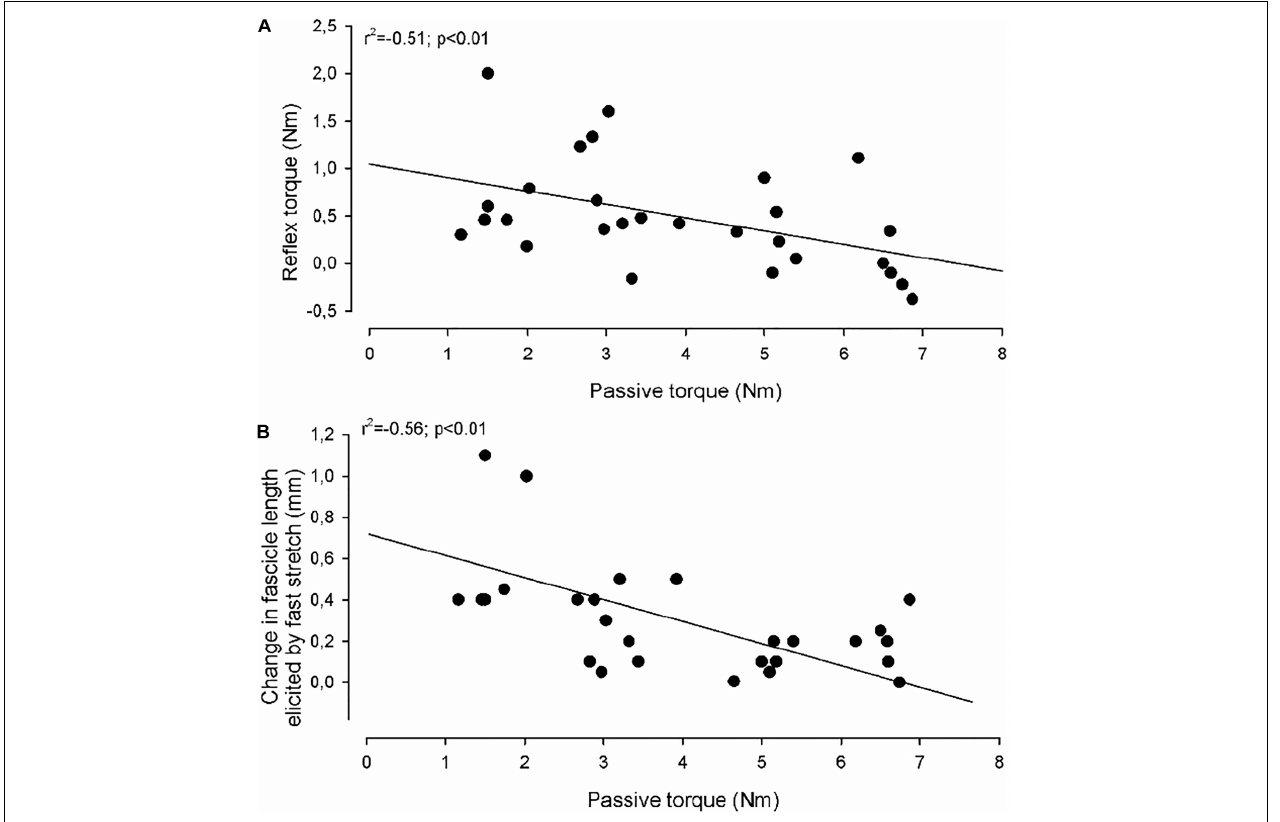
FIGURE 5 | Correlations. In (A) the reflex torque in individual adults with CP (elicited by the fast stretch) as a function of the passive torque (elicited by the slow stretch) is shown. (B) Shows the change in medial gastrocnemius fascicle length elicited by the fast stretch as a function of the passive torque (elicited by the slow stretch). The full lines indicate the regression lines for the data. The correlation coefficient and statistical significance of the correlation between the measurements using Spearman correlation analysis are given in the upper left part of the